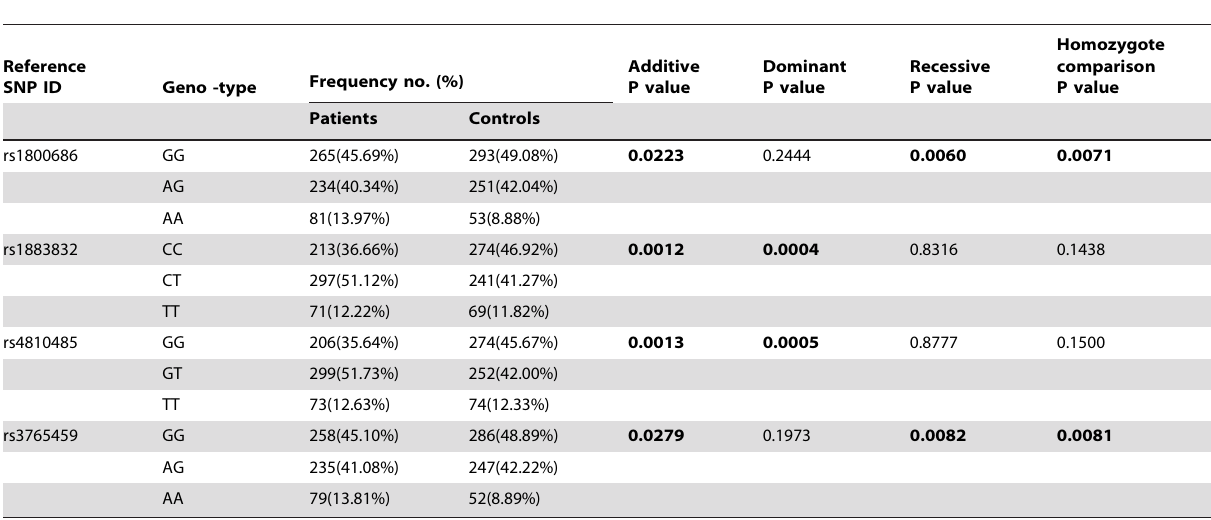
Table 1. Genotyping of CD40 gene SNPs in breast cancer patients and